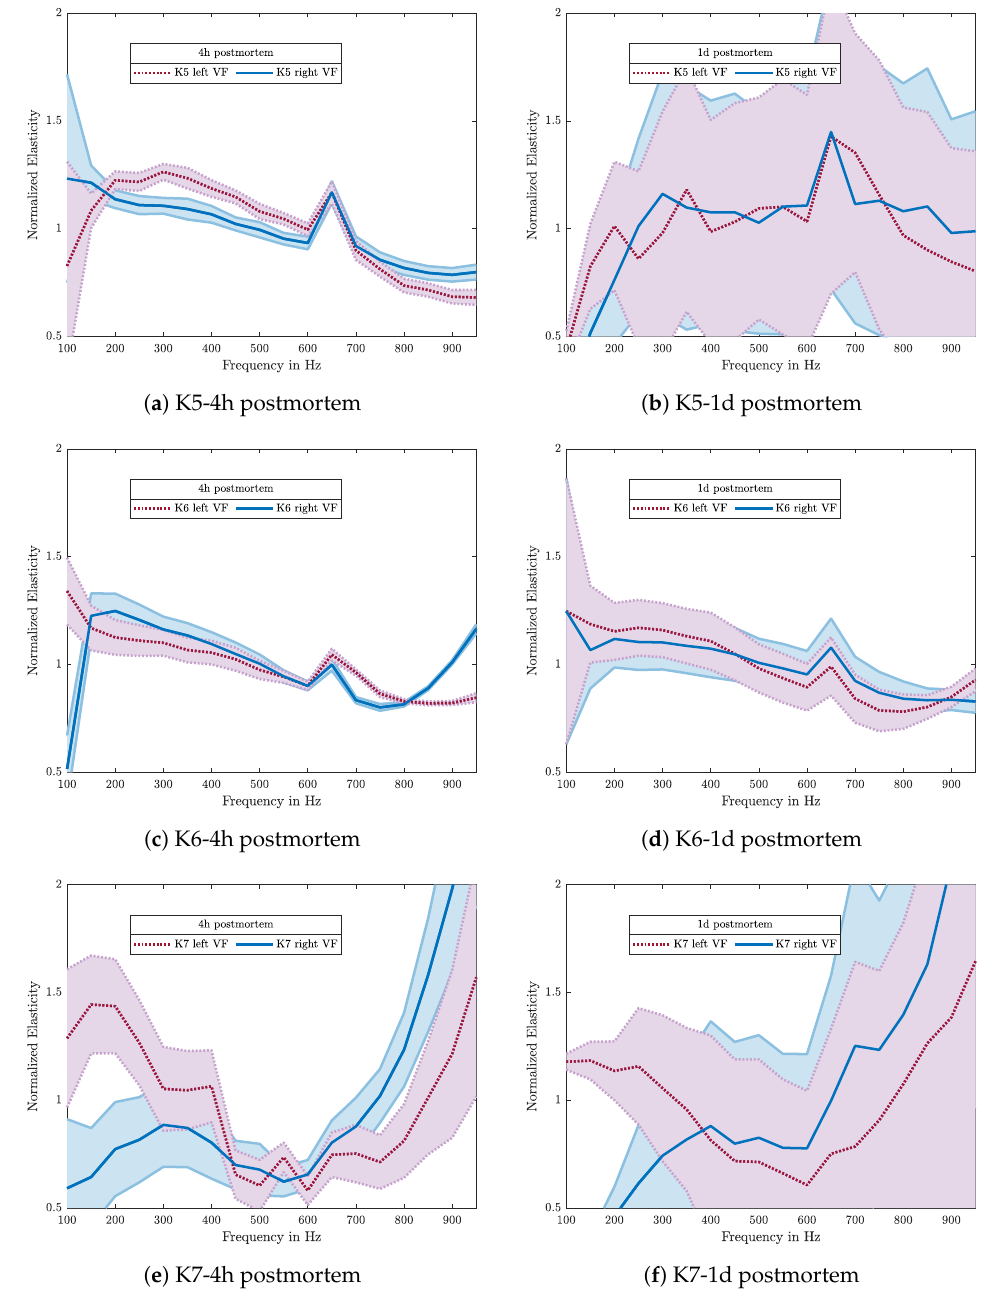
Figure 13. The normalized elasticities of samples K5, K6, K7 and their standard deviation (shadowed band) are shown, in which the left column indicates the results 4h and on the right one 1 d post- mortem. Same elasticity characteristics over frequency can be found within same VF but at different instants of measurement